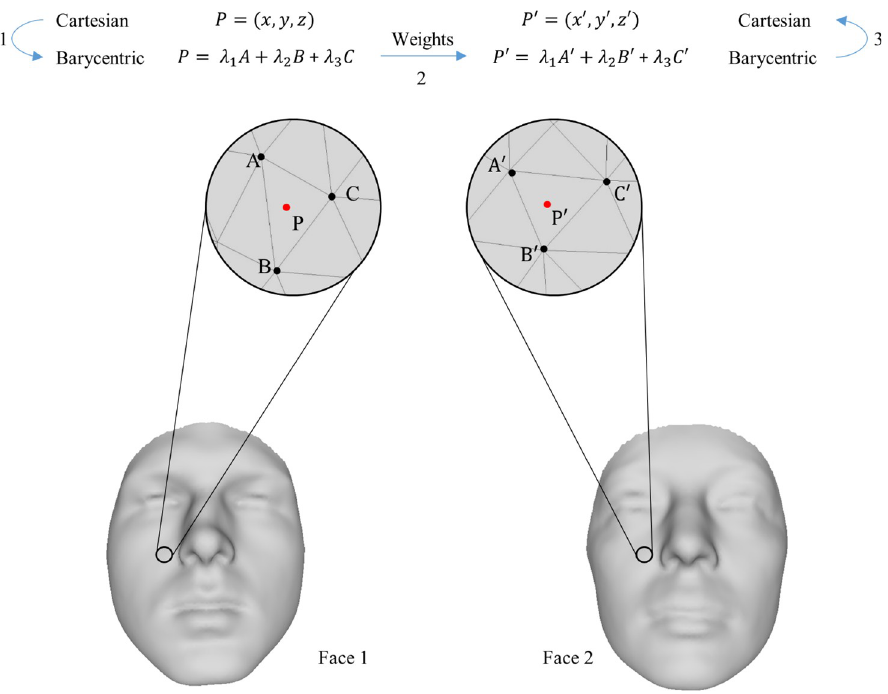
Fig 3. Using barycentric coordinates to transfer a landmark from one face to another. The barycentric coordinates of point P are calculated with respect to triangle ABC. The obtained weights are then used in combination with the Euclidean coordinates of triangle A 0 B 0 C 0 in Face2 to obtain the coordinates of P 0 .